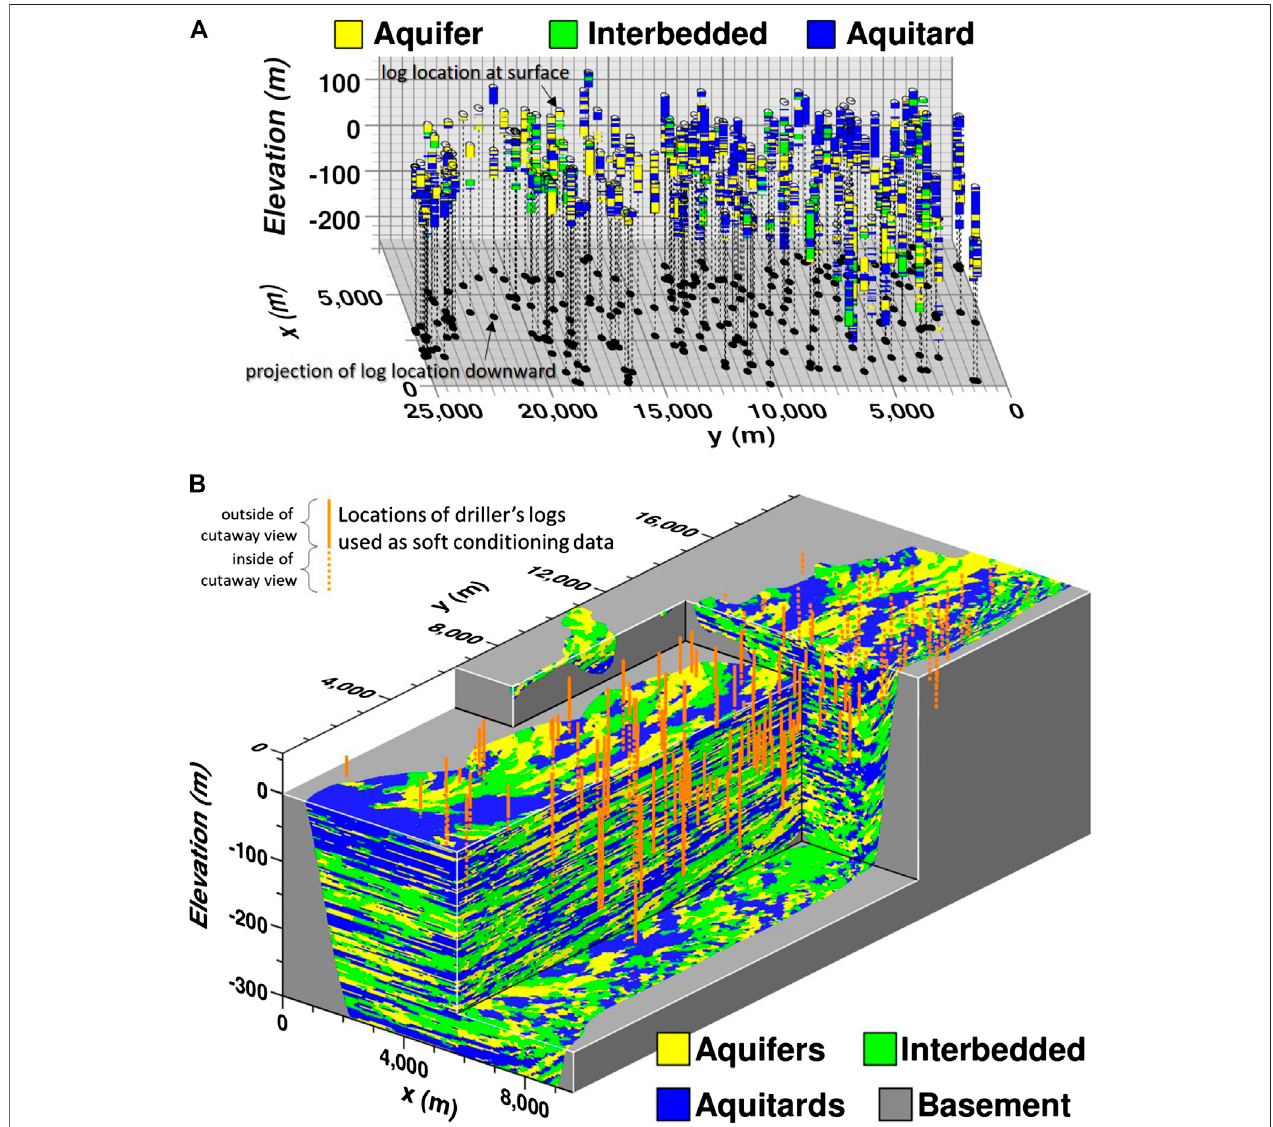
FIGURE 8 | (A) Hydrofacies interpretations of driller logs and (B) example 3-D simulation of aquifer system heterogeneity using tsim-s showing locations of conditioning data and variable dip and fl ow directions of anisotropy. Modi fi ed from Carle et al. (2006).